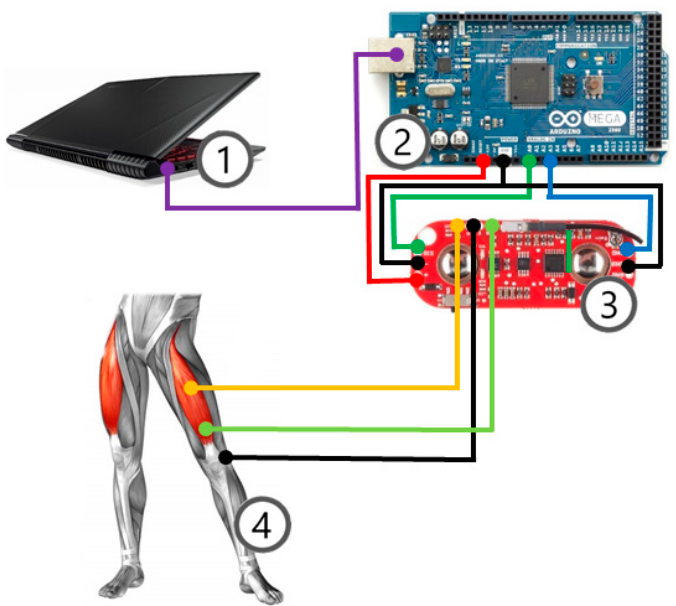
Figure 1. Setup wire configuration: ① personal computer, ② Arduino MEGA board, ③ surface electromyography (sEMG) sensor by Myoware System, ④ volunteer.